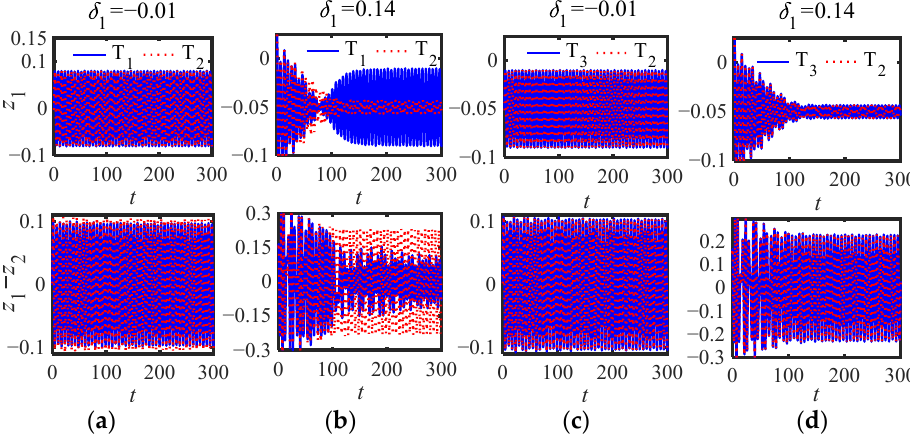
Figure 18. Time-domain responses ( κ = 1.1) of (6) with different parameter schemes ( a ) T 1 and T 2 ( δ 1 = − 0.01), ( b ) T 1 and T 2 ( δ 1 = − 0.14), ( c ) T 3 and T 2 ( δ 1 = − 0.01), ( d ) T 3 and T 2 ( δ 1 = − 0.14).